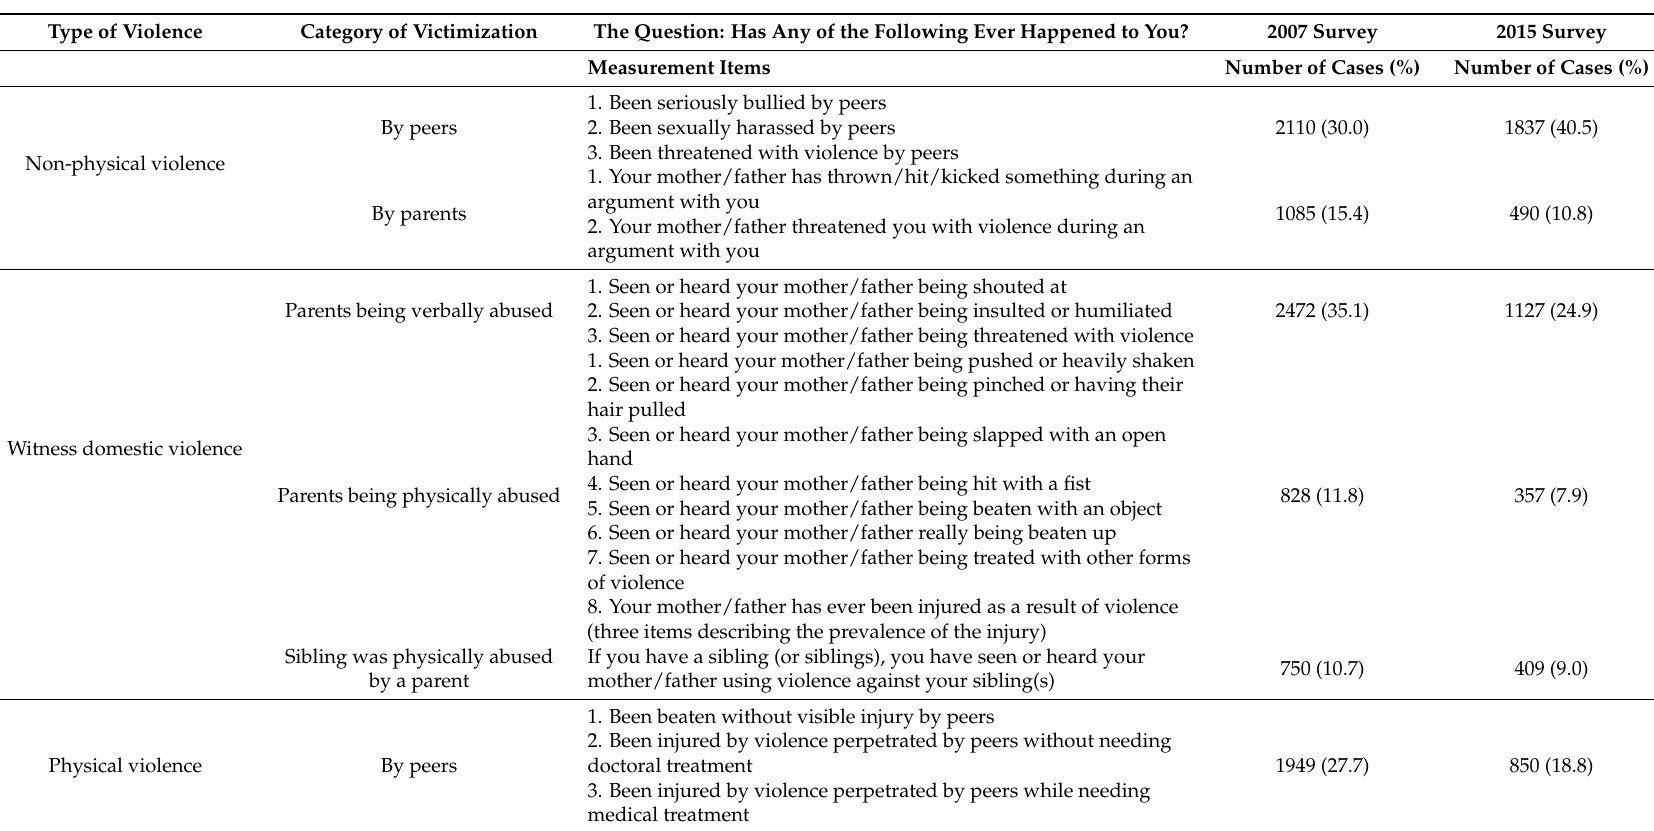
Table A1. Measures and lifetime prevalence of violence and abuse in Norwegian youth, as based on surveys collected in 2007 ( N = 7033) and 2015 ( N =